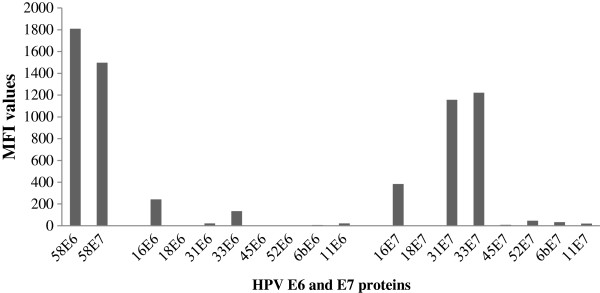
E6 and E7 antibodies status for HPV58 and other HPV types (16, 18, 31, 33, 45, 52, 6 and 11). MFI (Mean Fluorescence Intensity) values (y axis) are shown for the early proteins E6 and E7 of HPV58 and other HPV types (16, 18, 31, 33, 45, 6, 11) (x axis). Left: E6 and E7 MFI values for HPV58; Center and right: the MFI values for the other HPV types tested, grouped as E6 and E7, respectively.